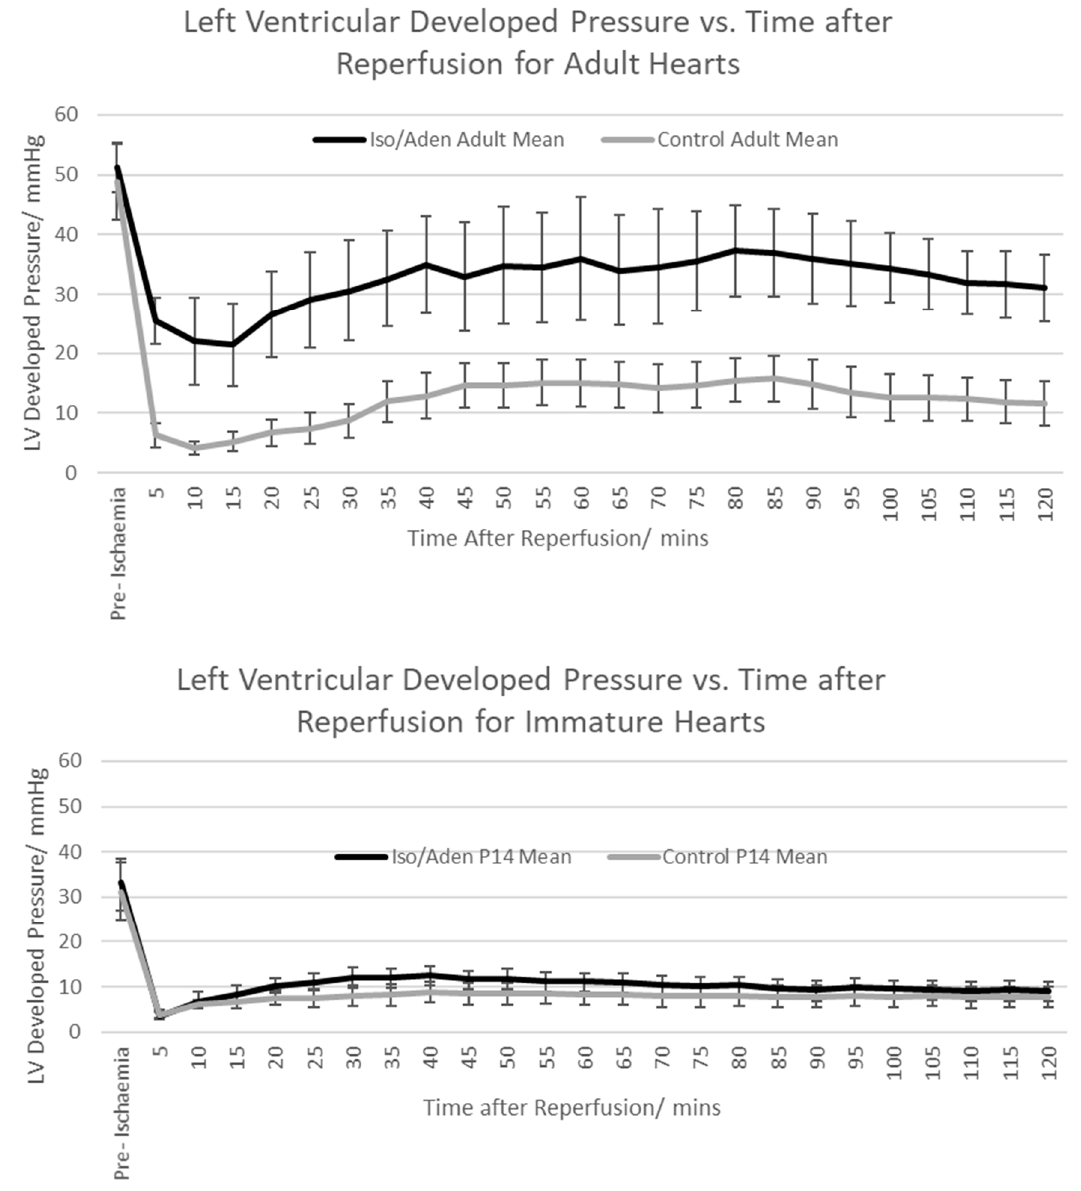
Figure 4. Time course of mean LVDP prior to and following reperfusion measured at 5 min intervals. Plotted as mean pressure ± SEM. ( Top ) panel—adult hearts; ( lower ) panel—14-day old immature hearts.